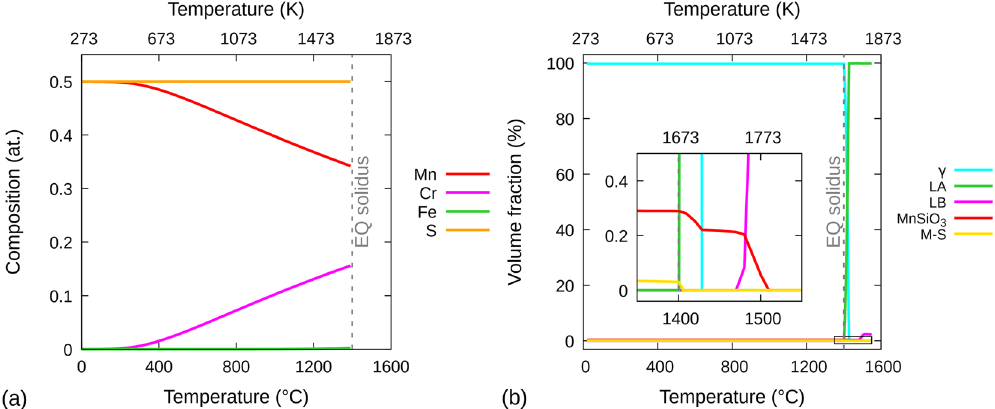
Figure 8. Equilibrium atomic composition and volume fraction curves. (a) Equilibrium atomic composition of only M–S (M = Mn, Cr and Fe), and (b) equilibrium volume fraction of γ-austenite, LA, LB, MnSiO 3 and M–S, as a function of temperature. ‘EQ solidus’ stands for equilibrium solidus. Gnuplot v5.4 (http:// www. gnupl ot. info) was used to prepare this